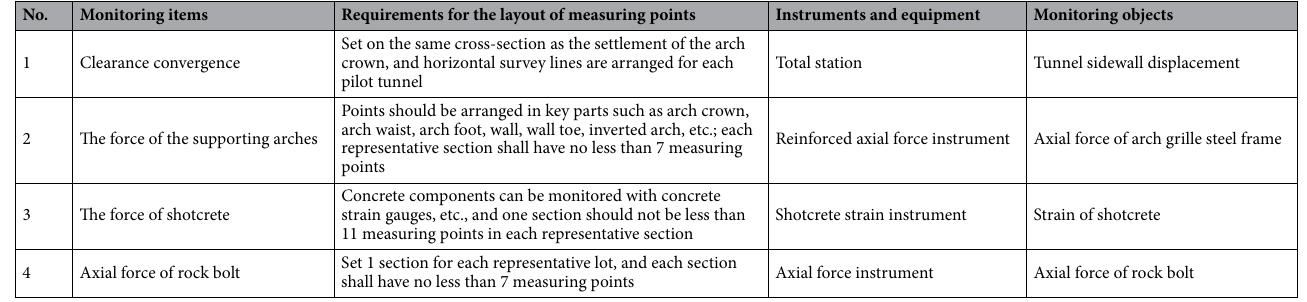
Table 12. Primary monitoring instruments.